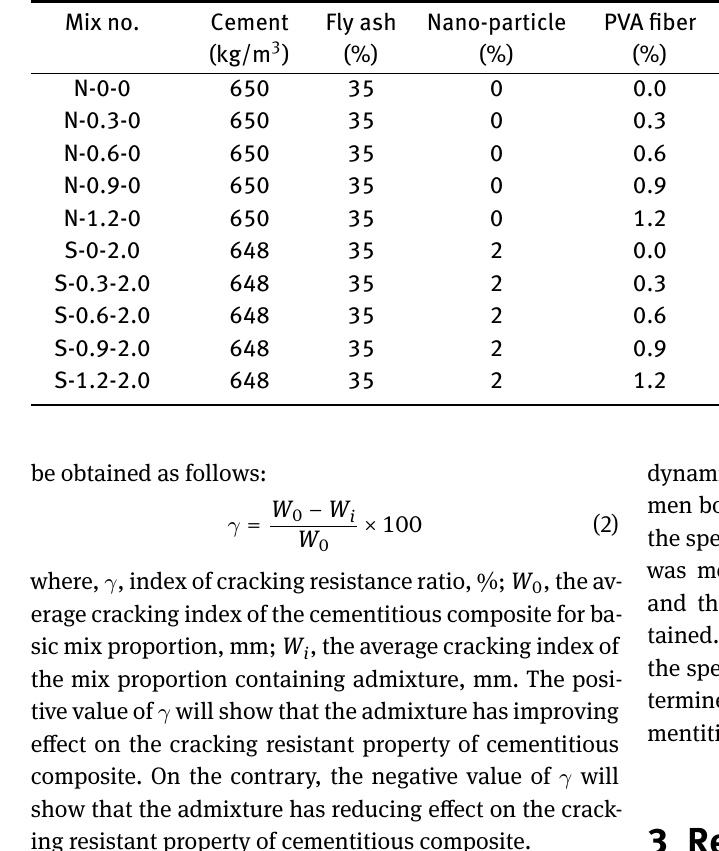
Table 4: Mix proportions of the cementitious composites Mix no. Cement Fly ash Nano-particle (kg/m 3 ) (%) (%) N-0-0